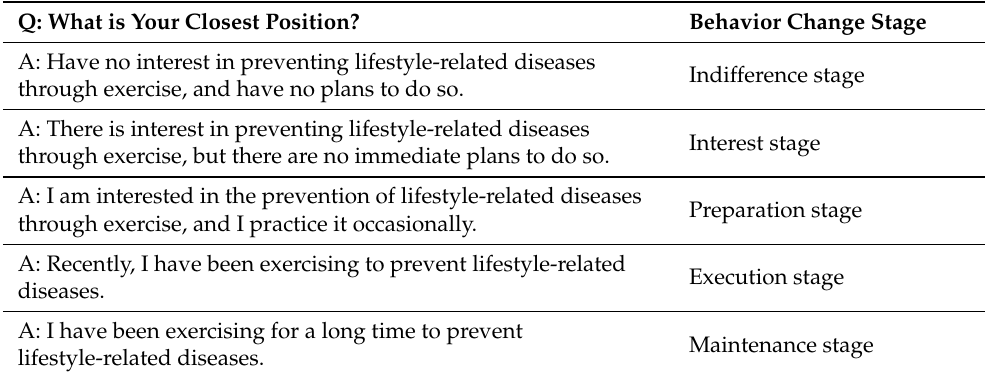
Table 2. Questions about behavior change